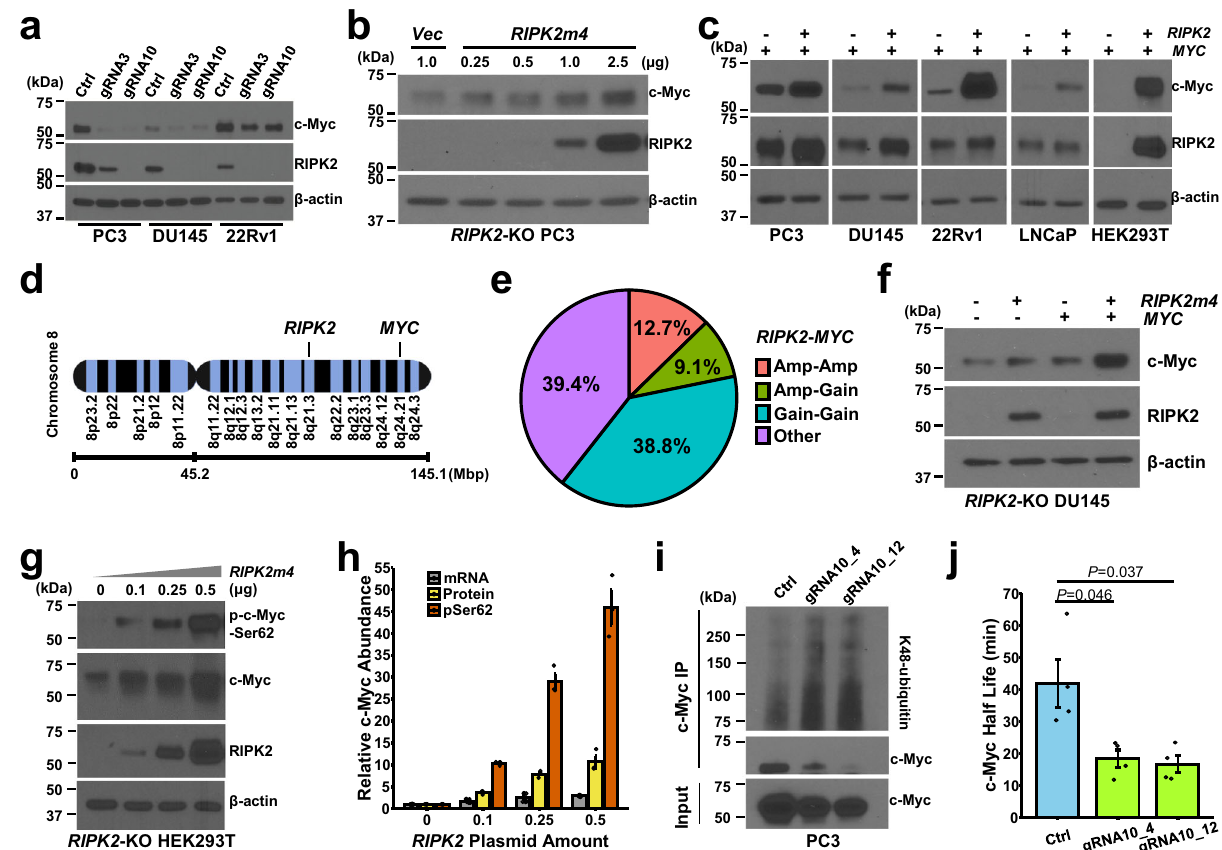
Fig. 4 RIPK2 upregulates the c-Myc protein by phosphorylating c-Myc-S62 and preventing c-Myc from proteasomal degradation. a – c Representative immunoblots of the indicated proteins of total lysates from a control or RIPK2 -KO (by gRNA3 or gRNA10) PC cells, b RIPK2 -KO PC3 cells transiently transfected with the indicated amounts of the RIPK2m4 plasmid, or c parental cells transiently co-transfected with vector or RIPK2 (2 µ g plasmid per cell line except for 0.5 µ g for HEK293T) and MYC (1 µ g per cell line except for 0.5 µ g for HEK293T) plasmids. Experiments were repeated twice independently with similar results ( a – c ). d Schematic of RIPK2 and MYC locations on human chromosome 8. e Pie chart of the percentages of mCRPC tissue specimens ( n = 655) with RIPK2 and MYC gene co-ampli fi cation/gain. f , g Representative immunoblots of the indicated proteins of total lysates from f RIPK2 -KO DU145 cells transiently transfected with RIPK2 (0.5 µ g) and/or MYC (0.5 µ g) plasmids or g RIPK2 -KO HEK293T cells transiently co-transfected with the indicated amounts of RIPK2 plasmid and 0.5 µ g MYC plasmid. Experiments were repeated three times independently with similar results ( f , g ). h Bar plot of the relative changes of MYC mRNA levels, c-Myc protein levels, or p-c-Myc-S62 protein levels ( n = 9, 3, and 3 biologically independent samples per group, respectively) in response to the ectopic expression of the indicated amounts of the RIPK2m4 plasmid in RIPK2 -KO HEK293T cells. i c-Myc was immunoprecipitated from control or RIPK2 -KO cells (clones #4 and #12). Immunoprecipitation product and total lysates were analyzed by IB for the indicated proteins. Experiments were repeated twice independently with similar results. j Bar graph of the half-lives of the c-Myc protein in control or RIPK2 -KO PC3 cells ( n = 4 biologically independent samples per group). Nominal p- values were determined by unpaired two-tailed Student ’ s t -test ( j ). Data are shown as mean ± SEM ( h , j